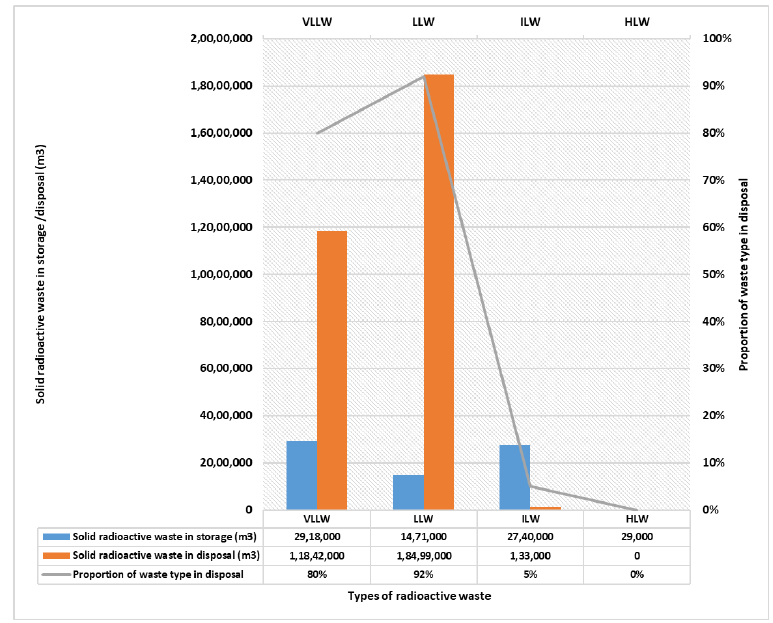
Figure 2. Nuclear waste inventory.